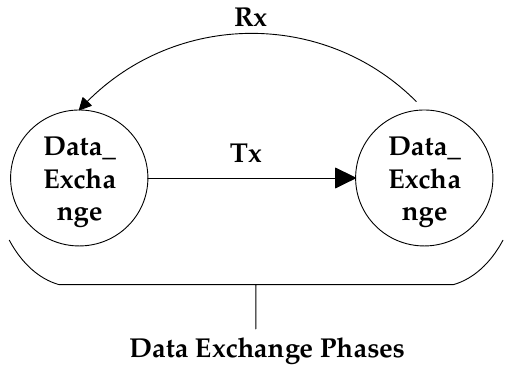
Figure 4. State transfer diagram of data exchange phase.